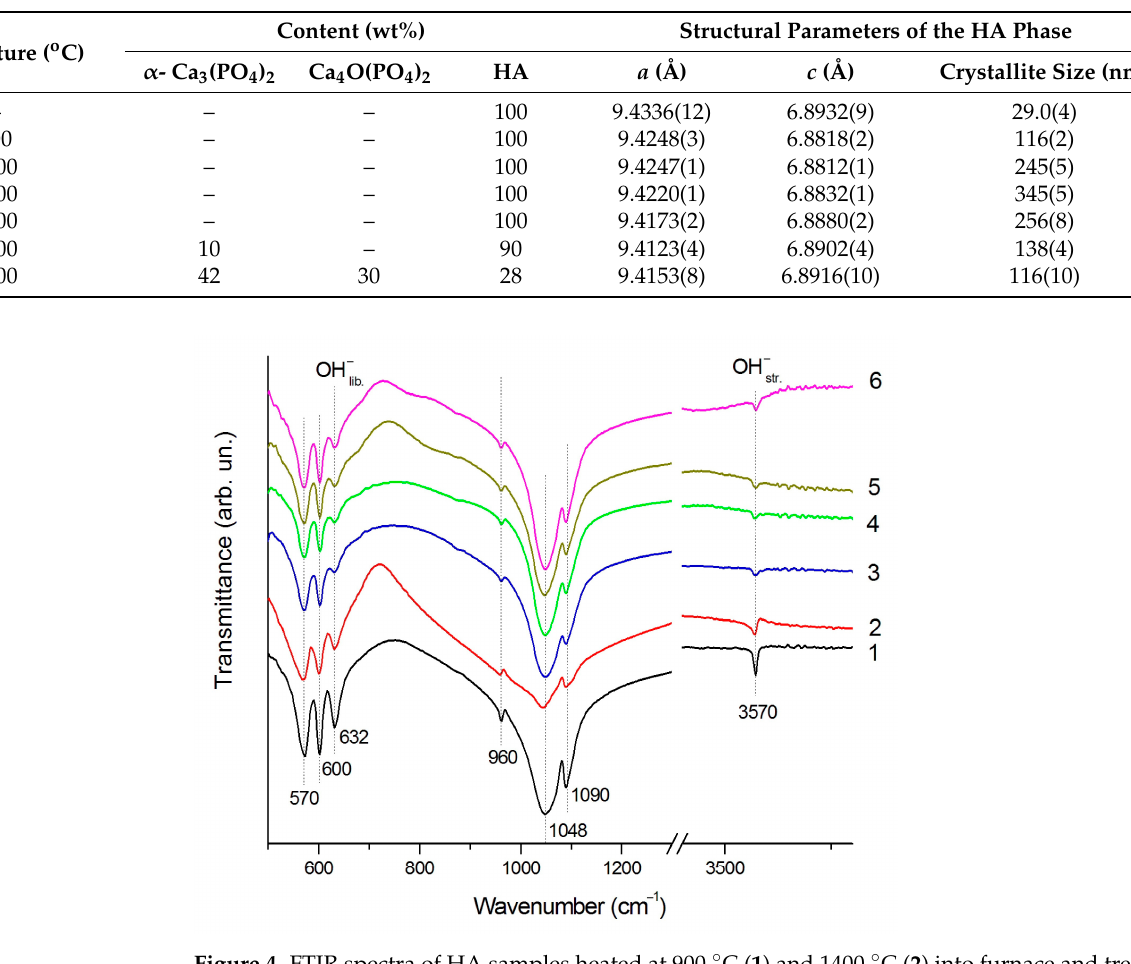
Figure 4. FTIR spectra of HA samples heated at 900 °C ( 1 ) and 1400 °C ( 2 ) into furnace and treated by 0.22 mm laser spot at 300 mm/s ( 3 ), 200 mm/s ( 4 ), 100 mm/s ( 5 ), and 50 mm/s ( 6 ).